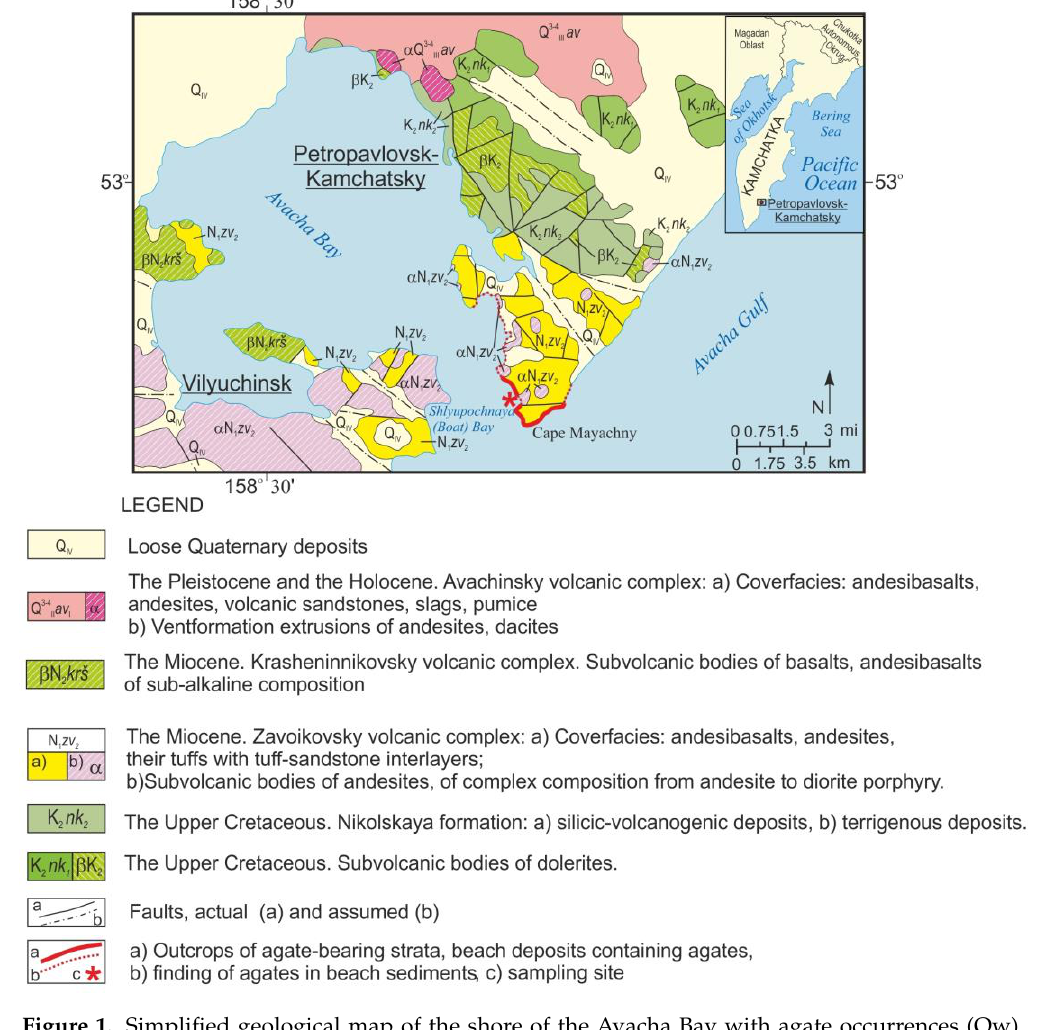
Figure 1. Simplified geological map of the shore of the Avacha Bay with agate occurrences (Qw), after Sheymovich [30].